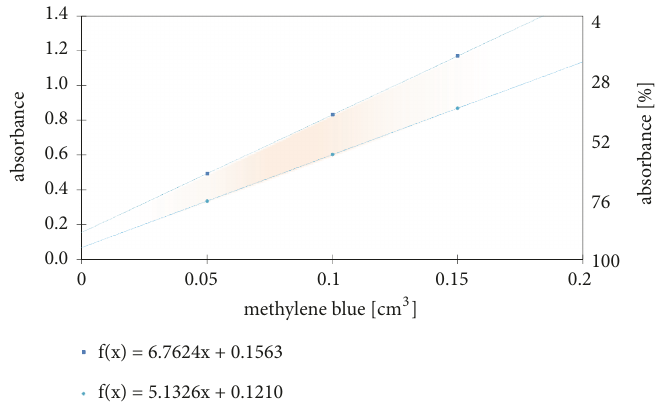
Figure 5: Range of the applicability of the method of measuring the concentration of